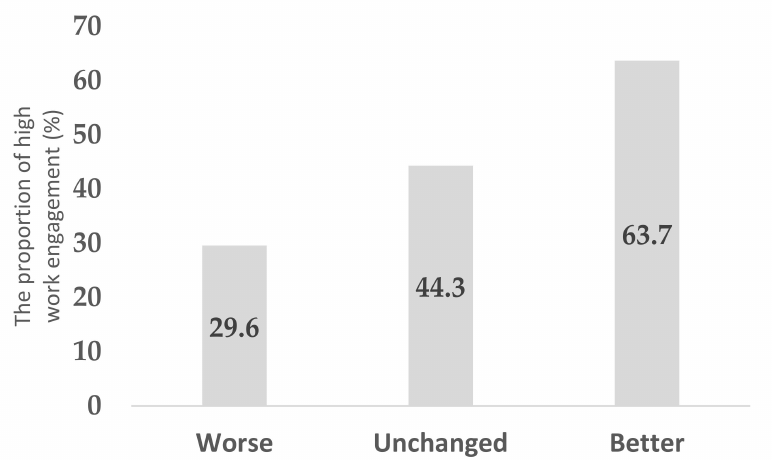
Figure 2. The association between the change in interaction with supervisors and higher work engagement among employees working from